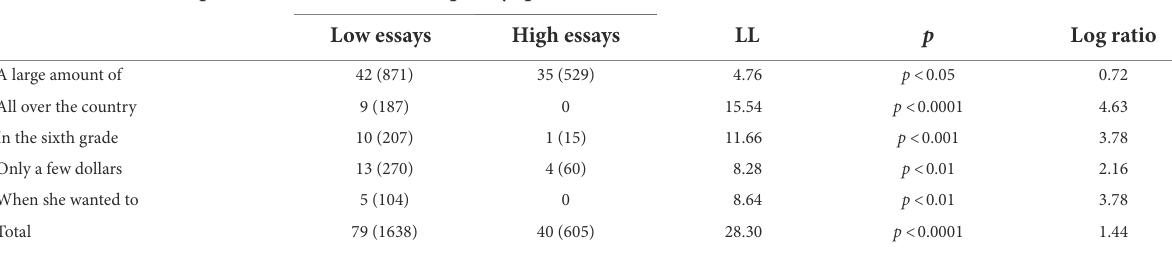
TABLE 7 4-Word referential sequences borrowed from